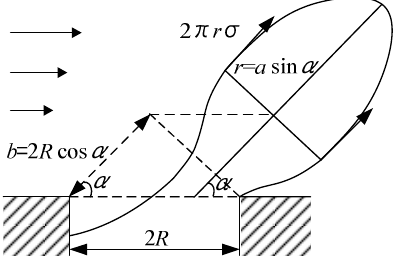
Fig. 9 Schematic diagram of bubble geometry during the separation